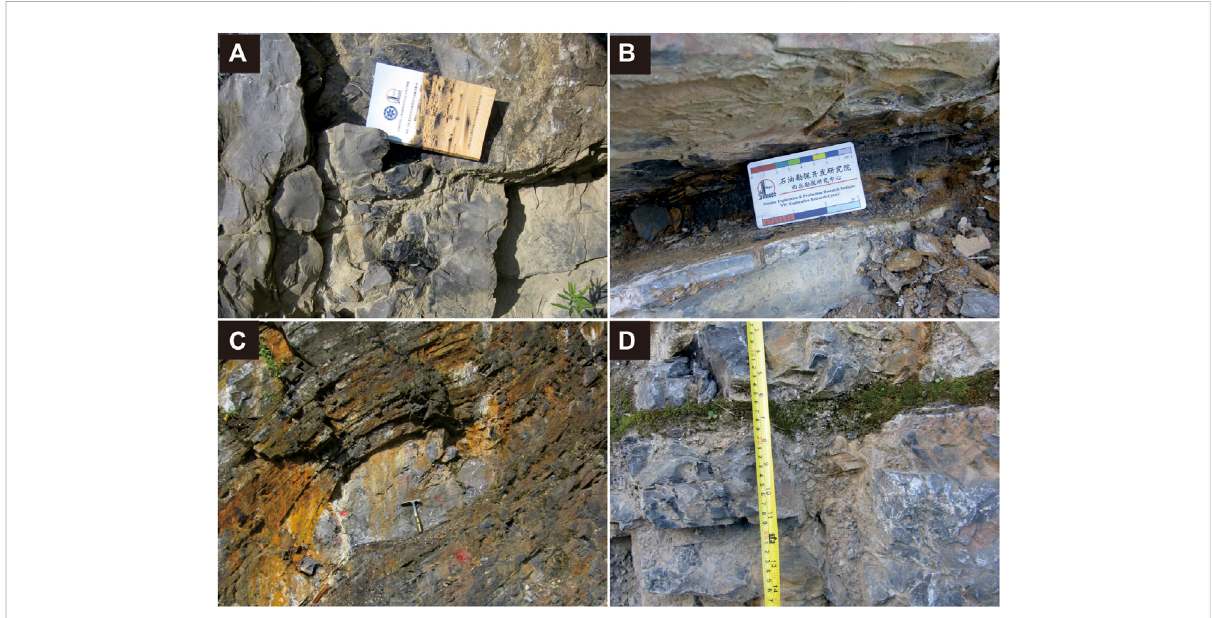
FIGURE 2 Fieldoutcropsinthestudyarea (A) Thick-layeredgray-blacksiliceousrock. (B) Thin-layeredgray-blacksiliceousshale. (C) Middle-layeredgray- black siliceous shale sandwiched with a limestone 2.0 m × 0.8 m lens. (D) Middle-layered dark-gray siliceous